Question: Sum up the contents of this chart in one sentence.
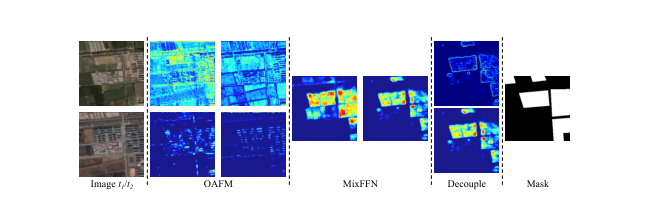
Answer: Visualization of heat maps generated by some modules.